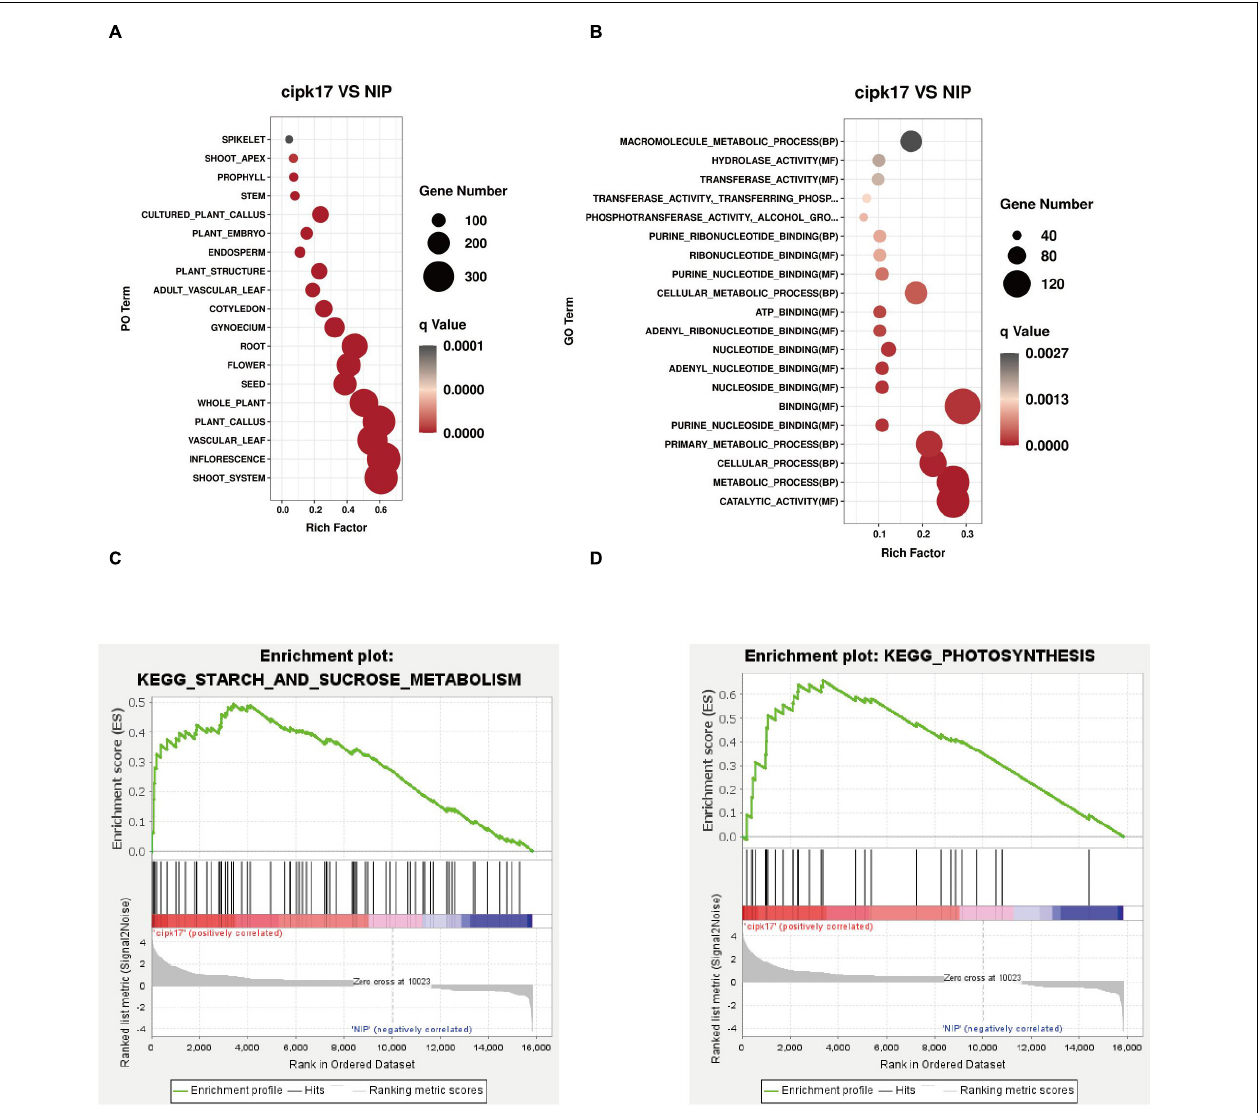
FIGURE 6 | Enrichment analysis of differentially expressed genes. (A) PO enrichment analysis of differentially expressed genes; (B) GO enrichment analysis of differentially expressed genes; (C) GSEA enrichment analysis of starch and sucrose metabolism in KEGG terms; (D) GSEA enrichment analysis of photosynthesis of KEGG